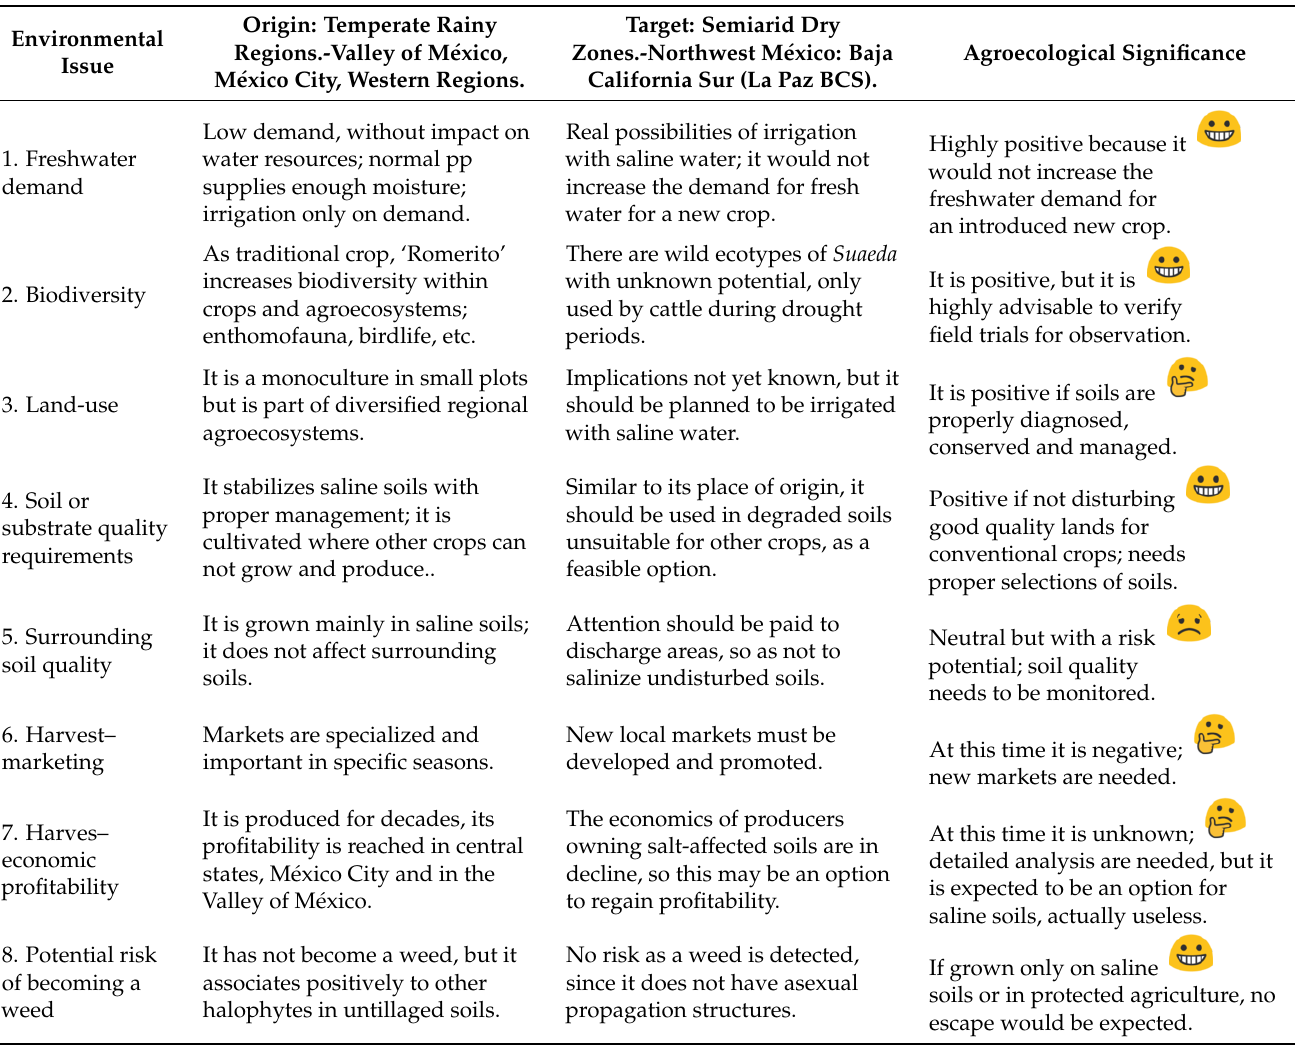
Table 4. Environmental links and possible implications associated with the introduction of Suaeda edulis (‘Romerito’) from temperate rainy zones to a semiarid region of Northwest México.